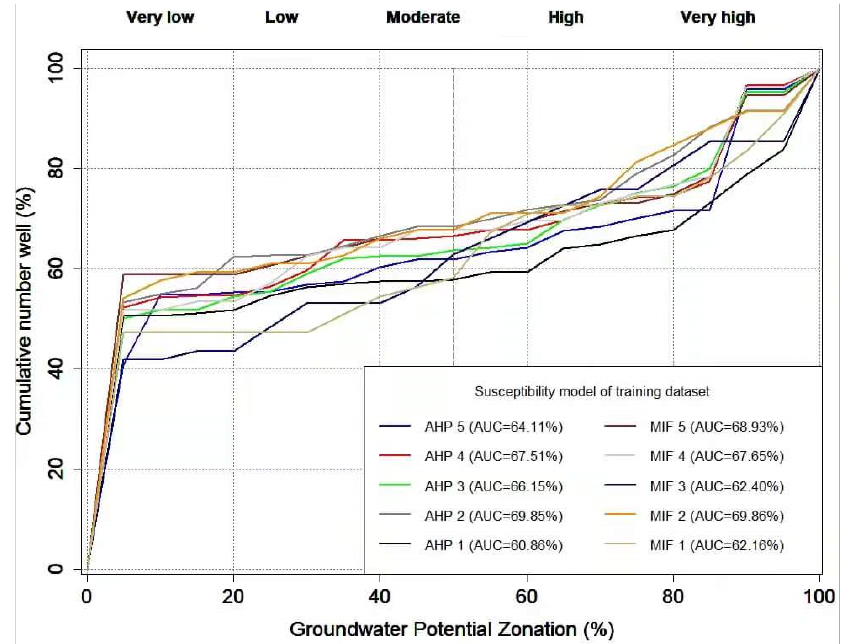
Figure 8. Results of the ROC for validation of groundwater potential maps using the AHP and MIF methods. MIF